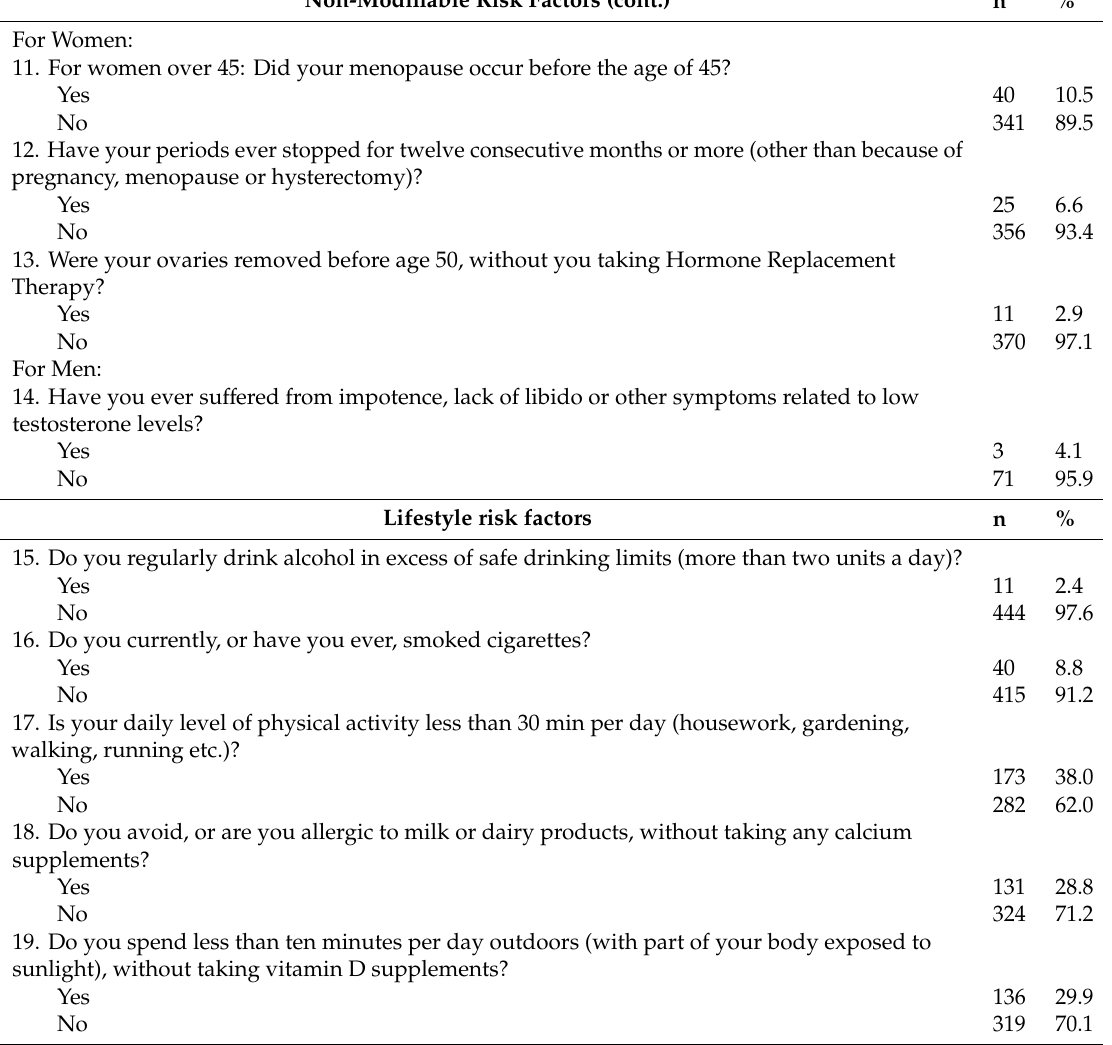
Table 3. IOF One-Minute Osteoporosis Risk Test of caregivers (non-modifiable and lifestyle risk factors) (n = 455). Non-Modifiable Risk Factors (cont.) n %